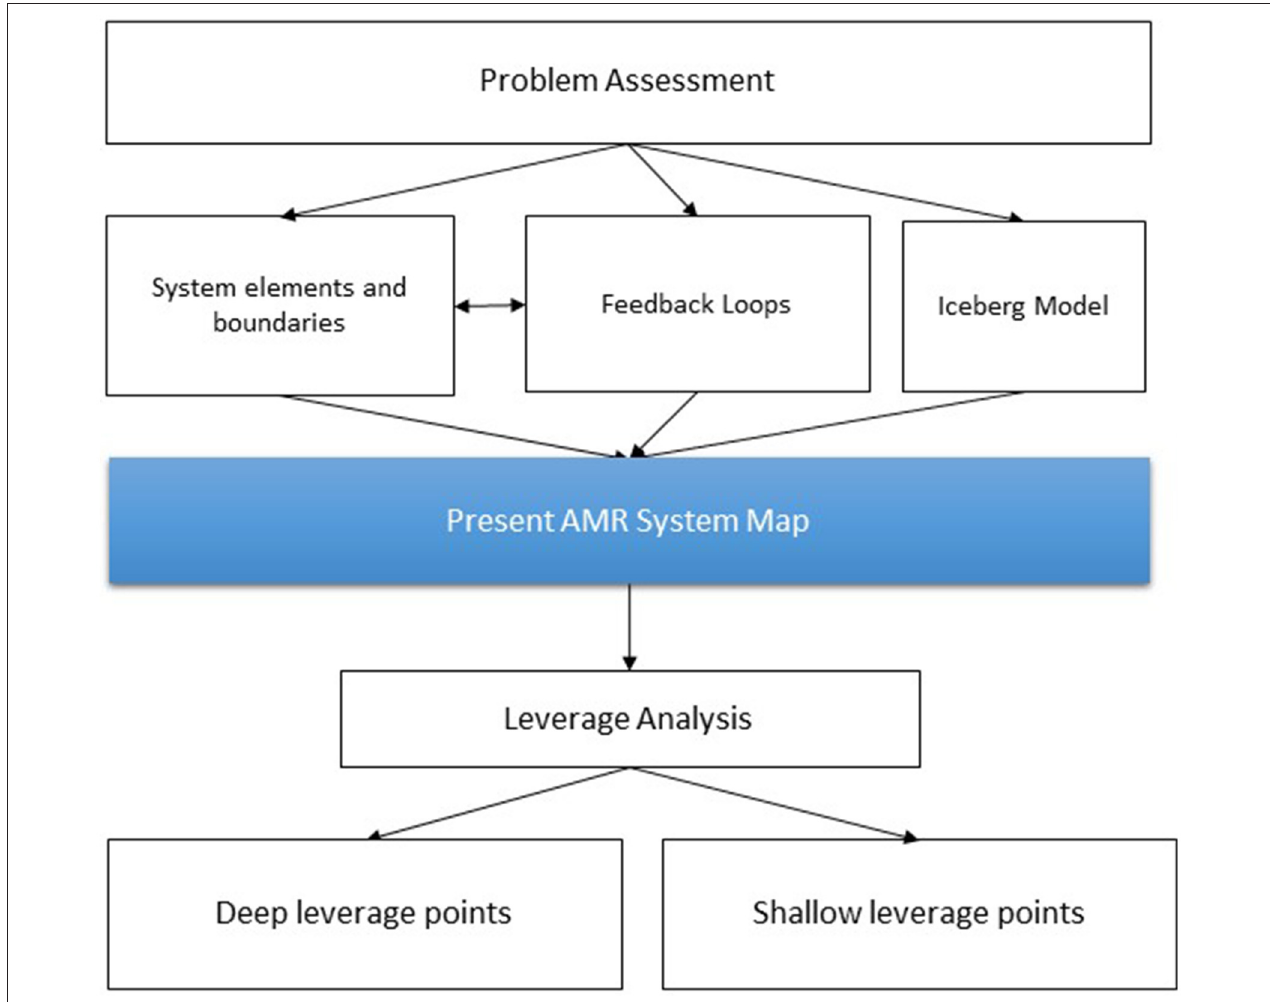
FIGURE 1 | Flowchart of study design using a systems thinking approach. In terms of the system mapping and identification of leverage points following Meadows (13) and Abson et al. (11) and in terms of the Iceberg Model following Monat and Gannon